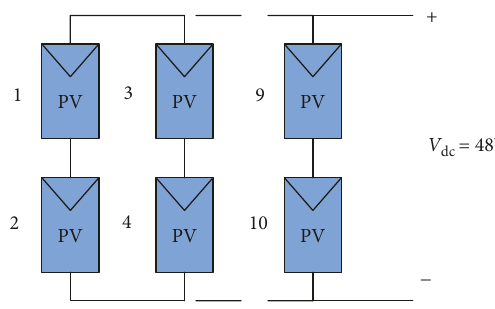
Figure 2: The PV generator rated at 3200Wp/48